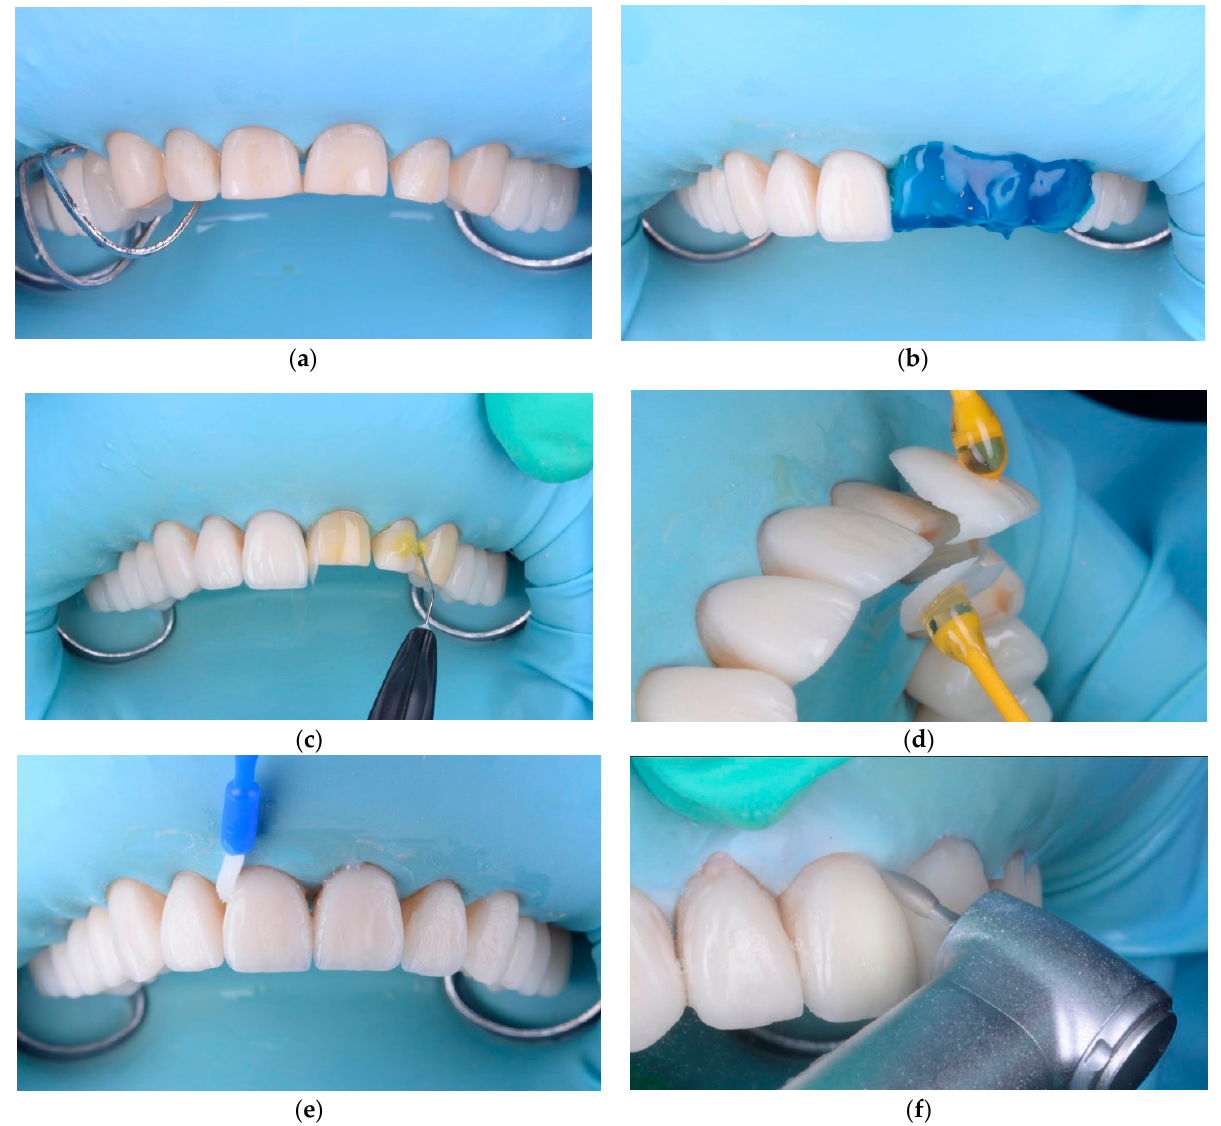
Figure 9. Intraoral cementation: ( a ) the rubber dam was applied; ( b ) the tooth was etched with 36% orthophosphoric acid for 45 s; ( c ) adhesive was applied and dried until a monolayer was obtained; ( d ) the veneers were cemented; ( e ) the excess cement was removed with a brush; ( f ) the margins were finished to obtain a good adaptation after cementation.